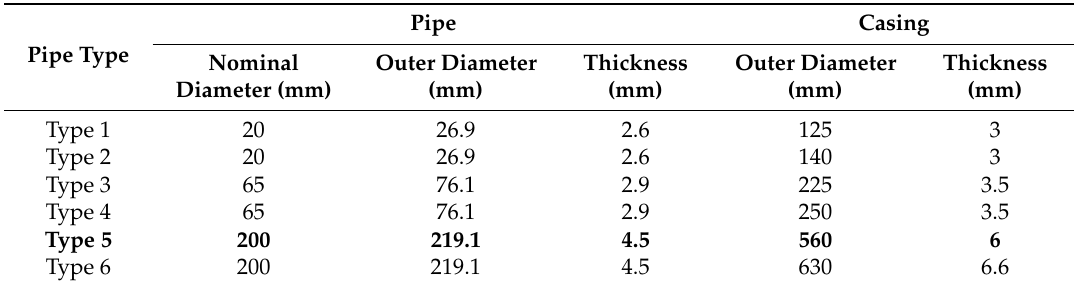
Table 1. Dimensions of various twin-pipes [26].